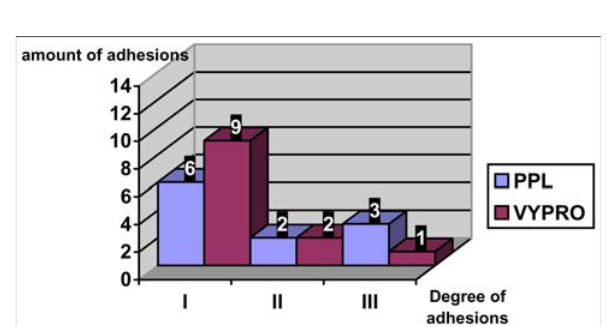
FIGURE 4 - Comparison between polypropylene and Vypro mesh concerning the degree of adhesions formation according to Shimanuki et al. scoring